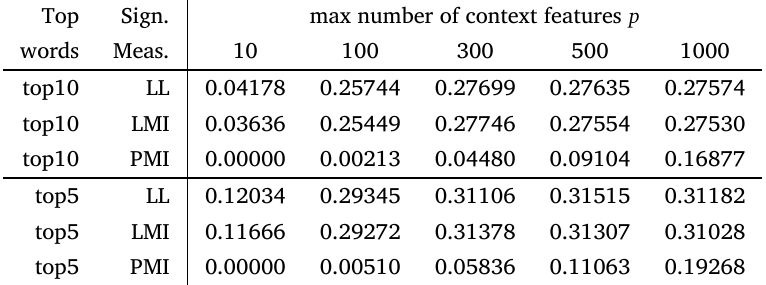
Table 3: Wordnet Path Similarity for 1000 frequent nouns for DTs computed on 10 million